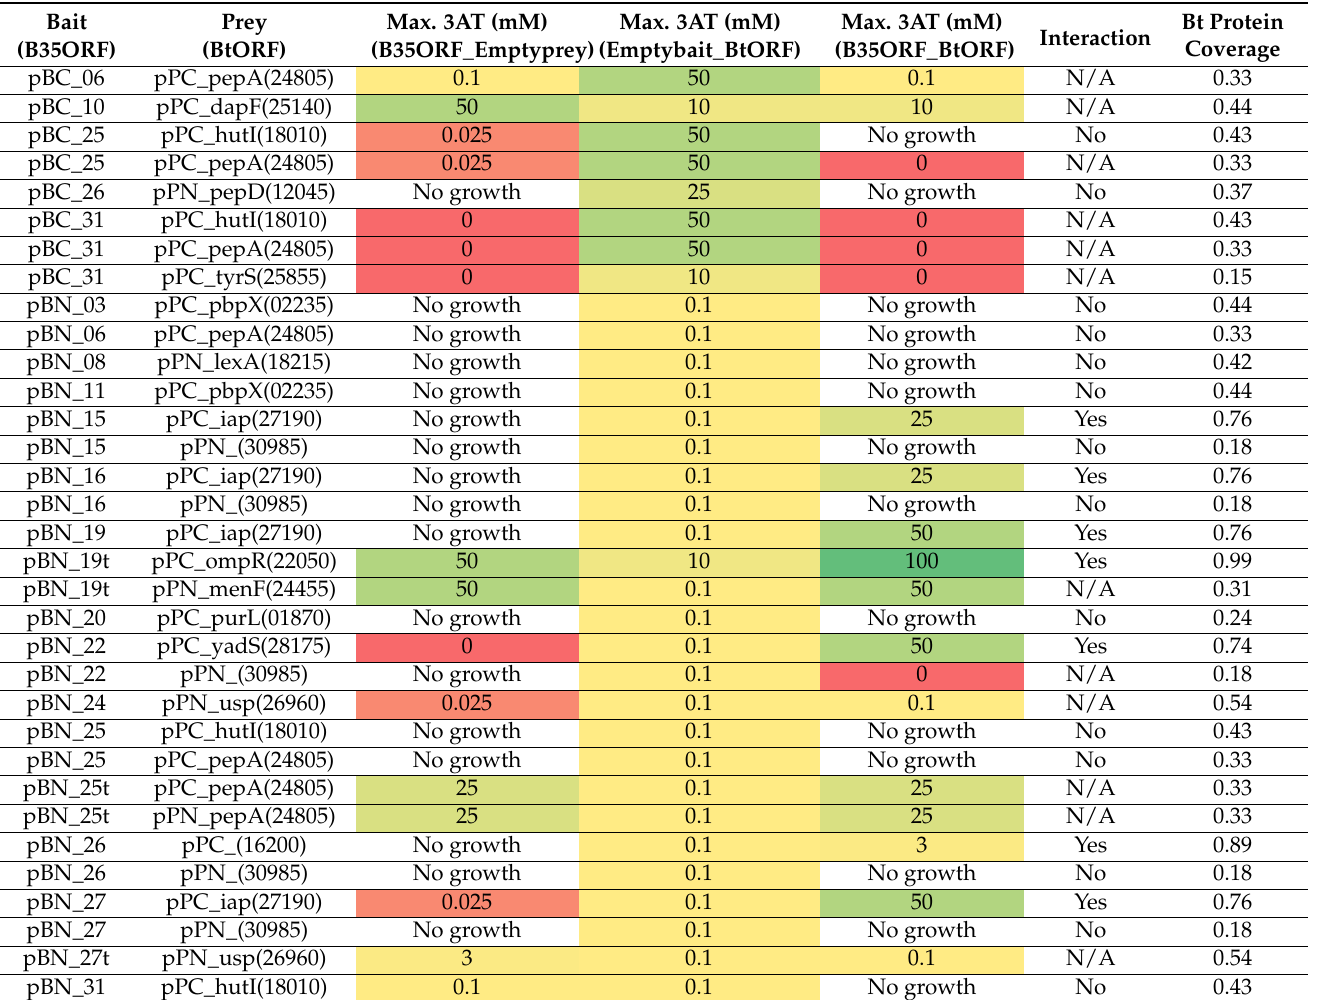
Table 3. Binary Y2H screening of 33 selected putative interactions between Bam35 (B35) baits and B. thuringiensis (Bt) preys using full-length proteins. The maximum 3AT concentration at which yeast growth was detected is gradually colored from red (low concentration) to green (high concentration). “No growth” indicates that no yeast growth was observed at any 3AT